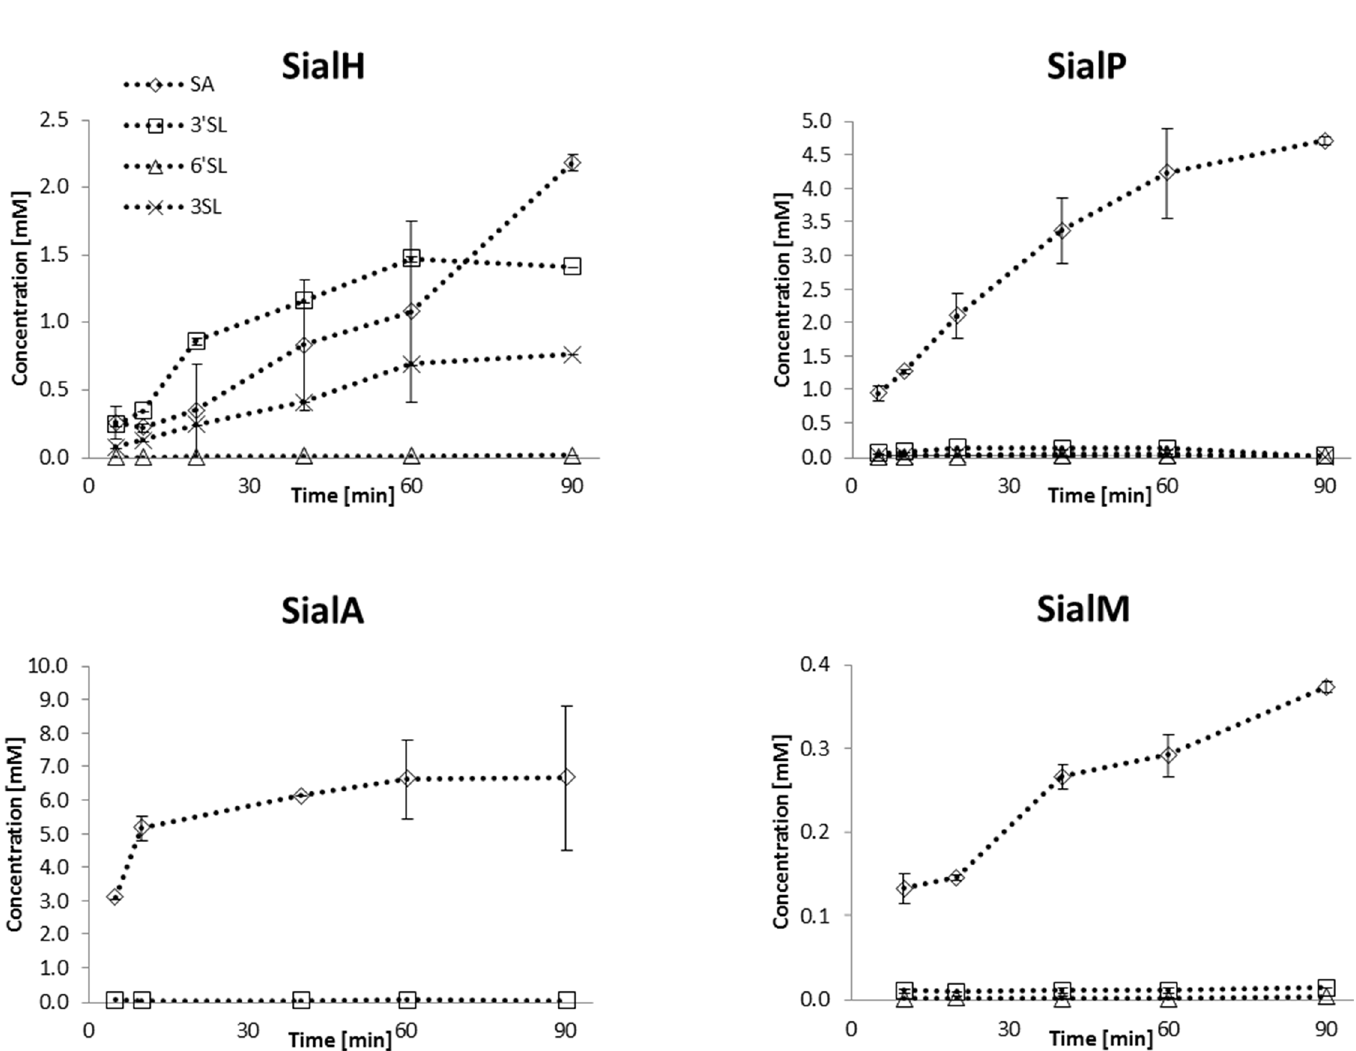
Fig 4. Activity of the four trans-sialidase candidates. The four candidate enzymes were used to catalyze reactions using CGMP as sialyl donor and lactose as acceptor. Formation of reaction products sialic acid (SA; all enzymes), 3 ’ -sialyllactose (3 ’ SL; SialH and SialP), 6 ’ -sialyllactose (6 ’ SL; SialP, SialA and SialM) and the novel trans-sialidase reaction product 3-sialyllactose (3SL; SialH and SialP) were monitored over a period of 90 minutes. Please note the difference in y -axis values. It is observed from the graphs that only SialH, which was the candidate with an aromatic sandwich, displayed a positive product- to-hydrolysis ratio. Thus, SialH can be classified as a trans-sialidase, whereas the remaining candidates are primarily hydrolytic sialidases.